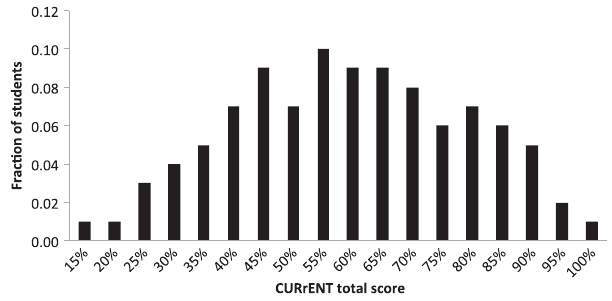
FIG. 3. Histogram of total scores on the CURrENT ( N ¼ 500 ). FIG. 4. Comparison of aggregate results on individual ques- tions and total score, for courses that have been characterized as either “ traditional ” or “ transformed ” (see text for discussion). Error bars represent the standard error of the mean.